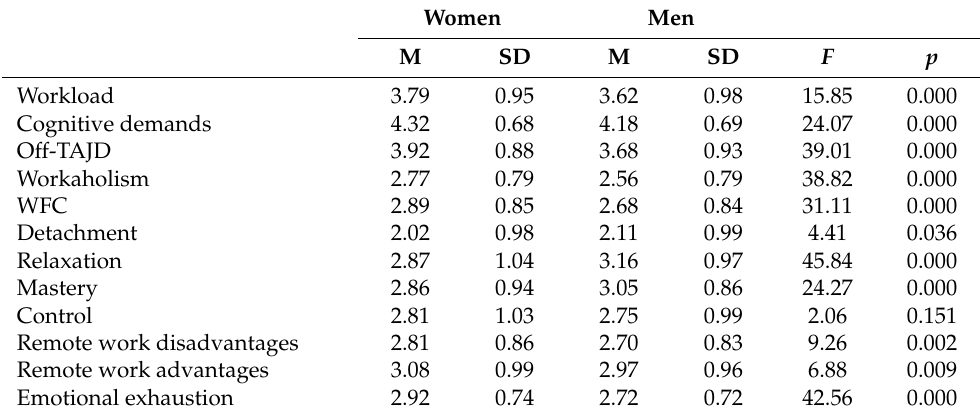
Table 4. Means, standard deviations, and ANOVA for the academics sample by gender.